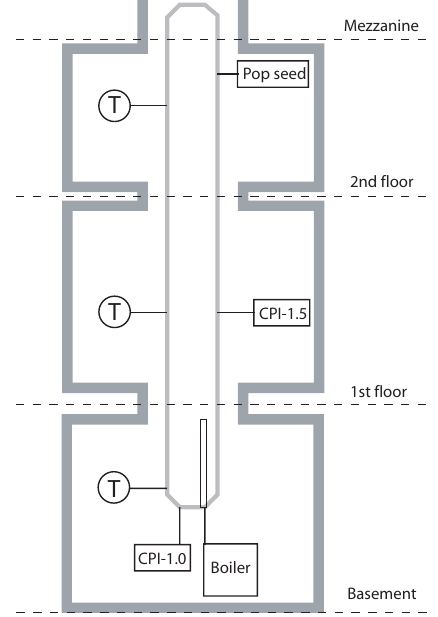
Fig. 1. A schematic of the Manchester Ice Cloud Chamber, which is situated on 3 floors of the Simon building at the University of Manchester. Temperature is measured at three positions within the chamber using two probes at each position; a boiler supplies the chamber with cloud drops and water vapour from the bottom, which rises through the chamber by buoyancy and mixing; two CPI’s are used to take images of cloud particles and construct quantitative size distribution information at the base of the chamber and in the middle of the chamber; a “pop seed”, which is a compressed airline connected to a solenoid valve that extends into the chamber via a 1/4 00 pipe, is used to nucleate the ice phase at the top of the chamber, which then grows by vapour diffusion and aggregation as it falls to the bottom of the chamber.